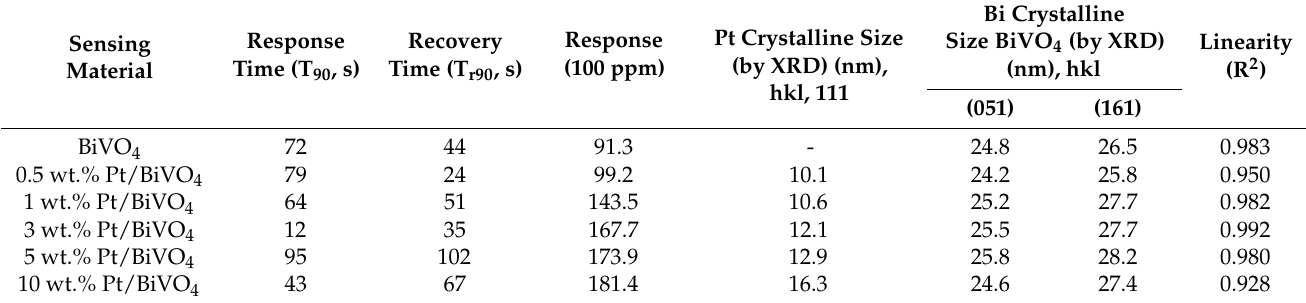
Table 1. Comparison of the NO 2 -sensing performance of different contents of Pt/BiVO 4 nanocomposites.